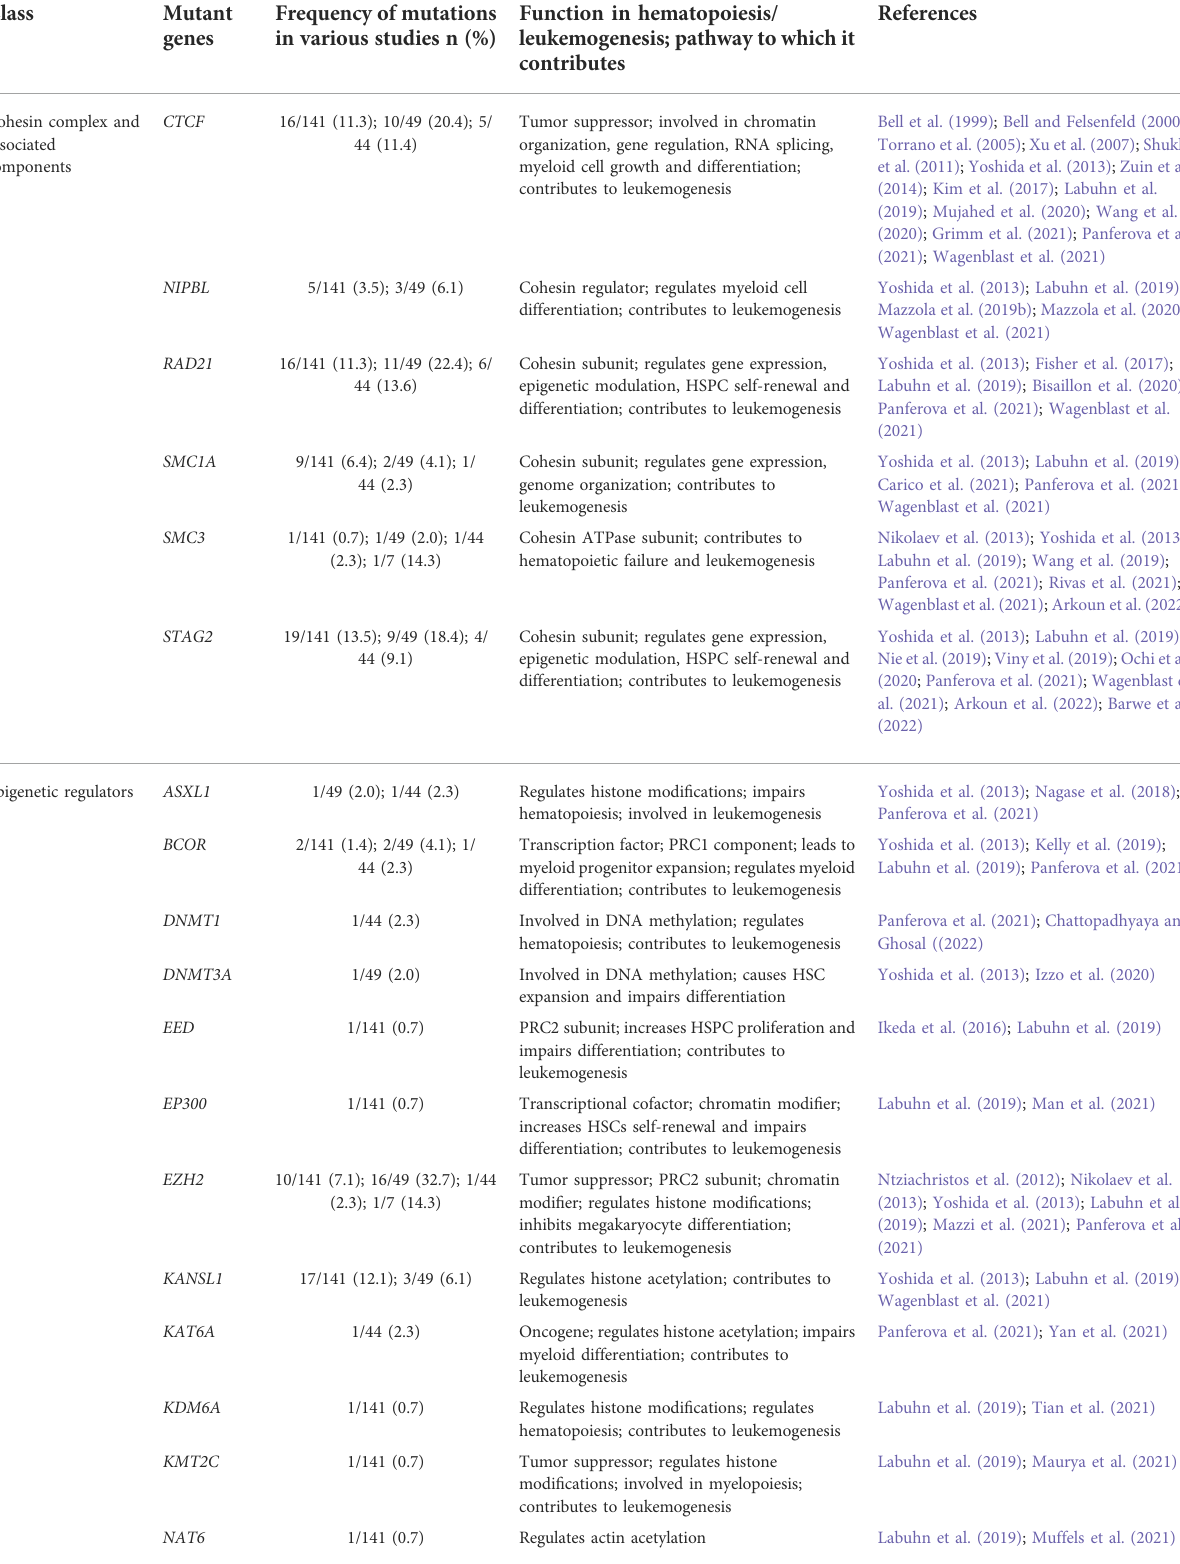
TABLE 2 Recurrent somatic mutations reported in myeloid leukemia associated with Down